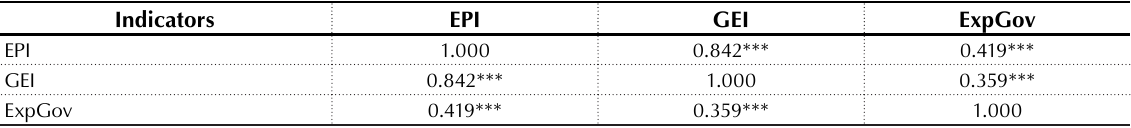
Table 5. Correlation matrix of Government Effectiveness Index (GEI), level of government expenditures (ExpGov) and Environmental Performance Index (EPI) of 135 countries